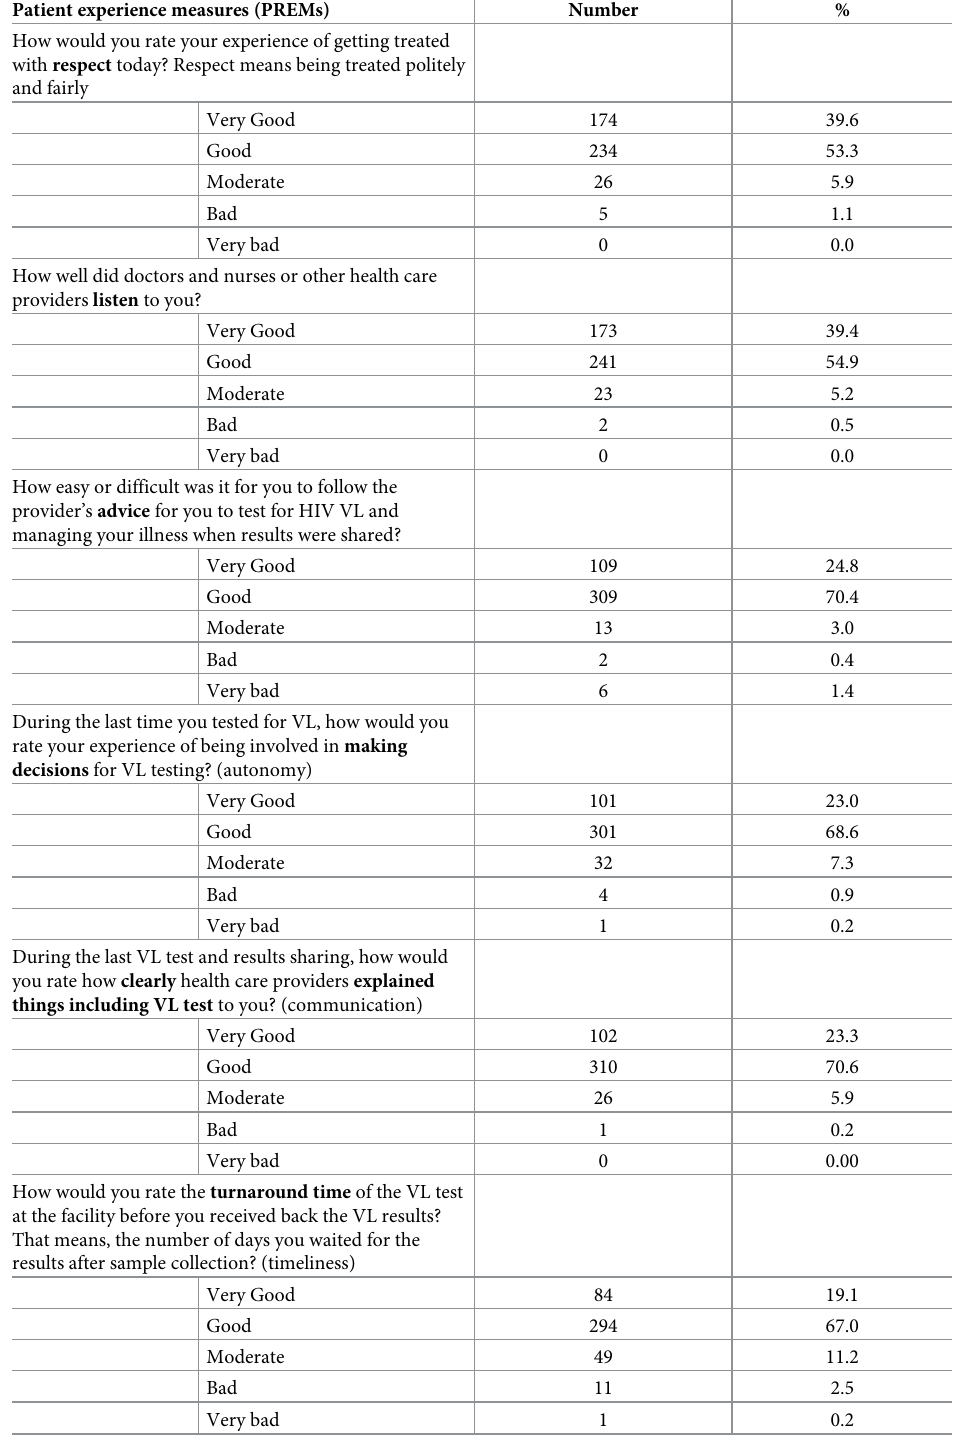
Table 2. Patients reported experience measures (PREMs), N = 439. Patient experience measures (PREMs) Number % How would you rate your experience of getting treated with respect today? Respect means being treated politely and fairly Very Good 174 39.6 Good 234 53.3